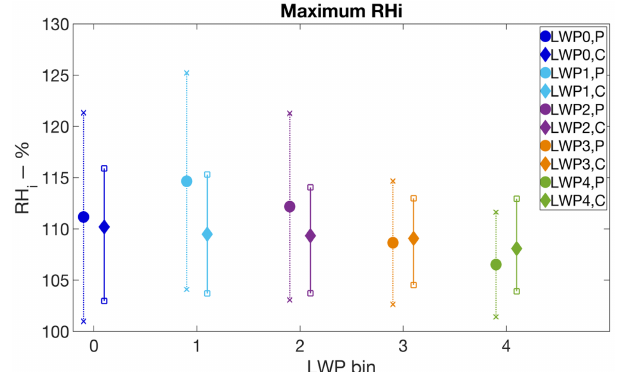
Figure 6. Mean in-cloud RHi for clean and polluted clouds for each LWP scenario. Diamond markers with solid line indicate clean clouds; circle markers with dashed line represent polluted cases. The bars span the 20–80th percentile of the RH i max distribution for each bin.